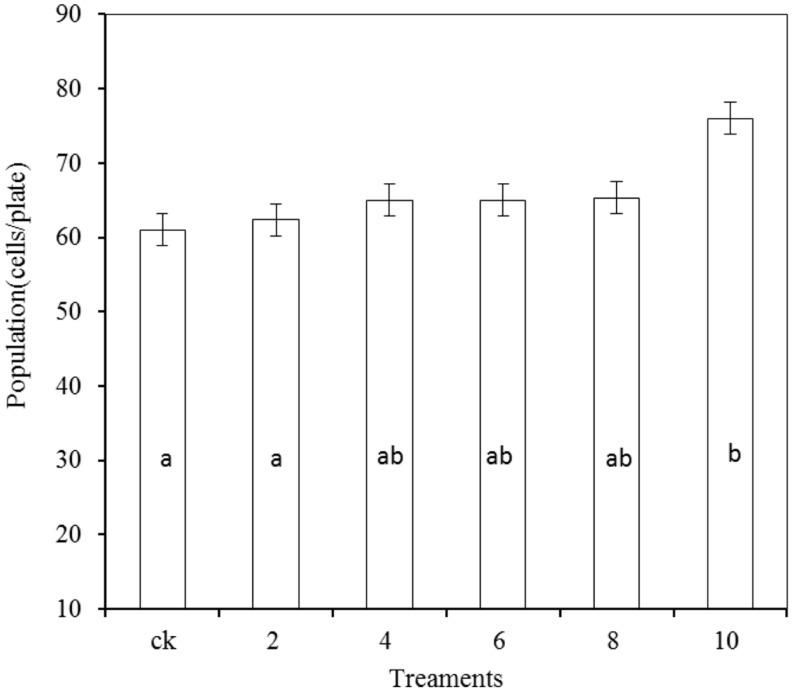
Effects of PA at various concentrations on antagonistic yeast. Treatments are as follows: CK = R. mucilaginosa (1 × 104 CFU/mL), (2, 4, 6, 8, 10) = R. mucilaginosa (1 × 104 CFU ml-1) + PA at different concentrations (2, 4, 6, 8, and 10 μmol/mL). Each value is the mean of two experiments. Bars represent standard deviations. Different letters indicate significant differences (P < 0.05) according to the Duncan’s multiple range test.